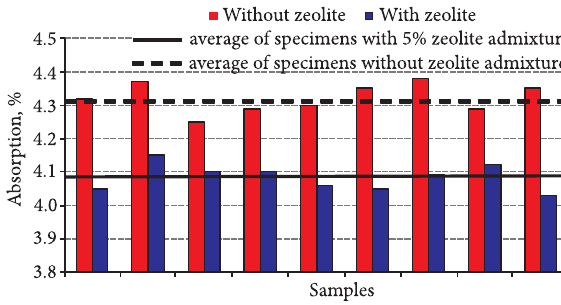
Fig. 4. Absorption of paving blocks after 28